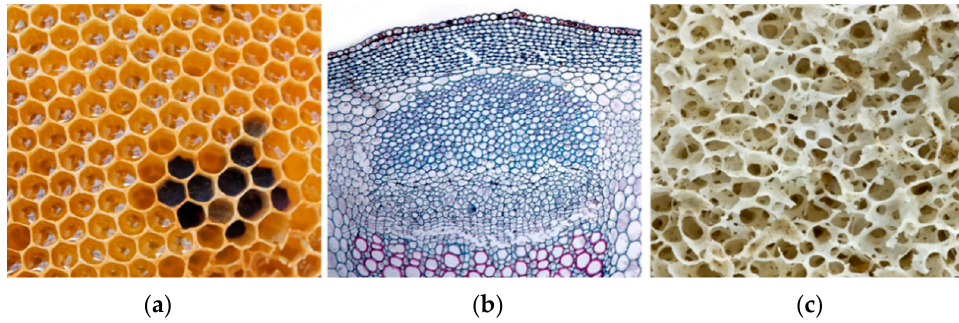
Figure 2. Three examples of aperiodic architected cellular materials in nature: ( a ) honeybee nest; ( b ) cross-section of a sunflower stem; and ( c ) trabecular bone (attribution for sunflower stem: John Bebbington; for trabecular bone: Patrick Siemer, both images reproduced under Creative Commons- CC BY-NC-SA 2.0).